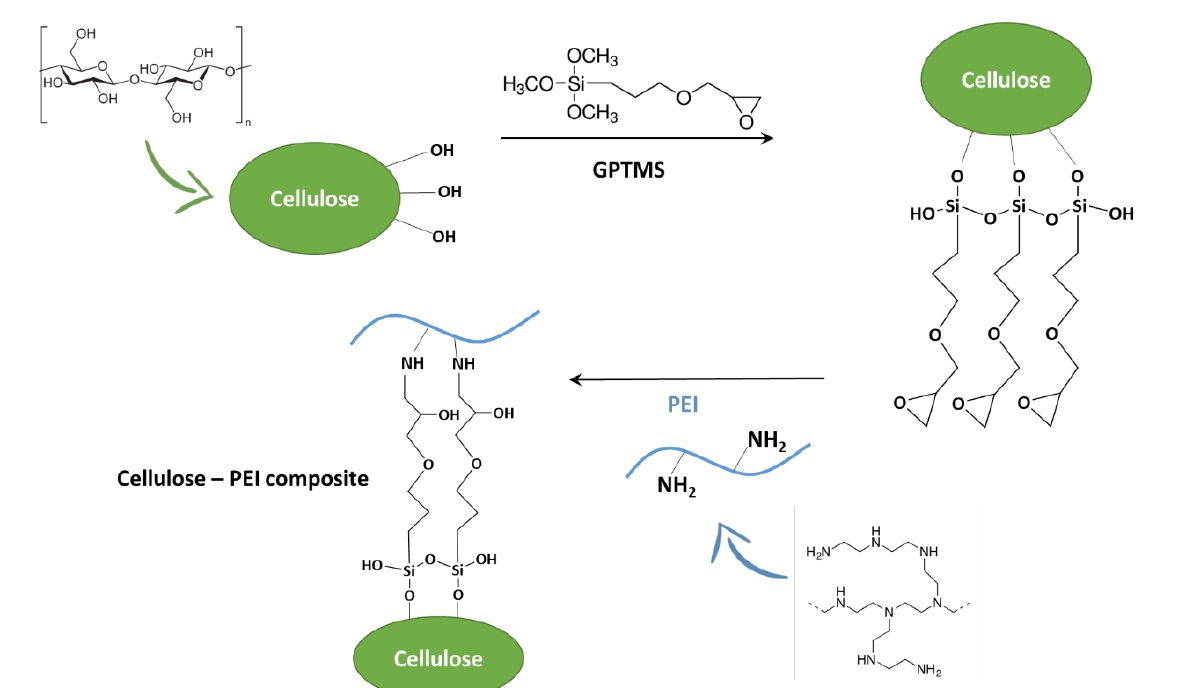
Scheme 6. Cross-linking between PEI and cellulose in presence of